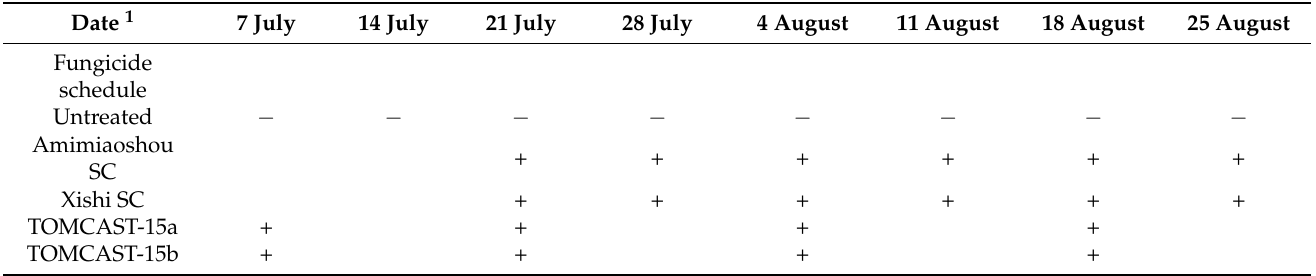
Table 2. Dates of spraying fungicide to control potato early blight during the experiment in 2021.